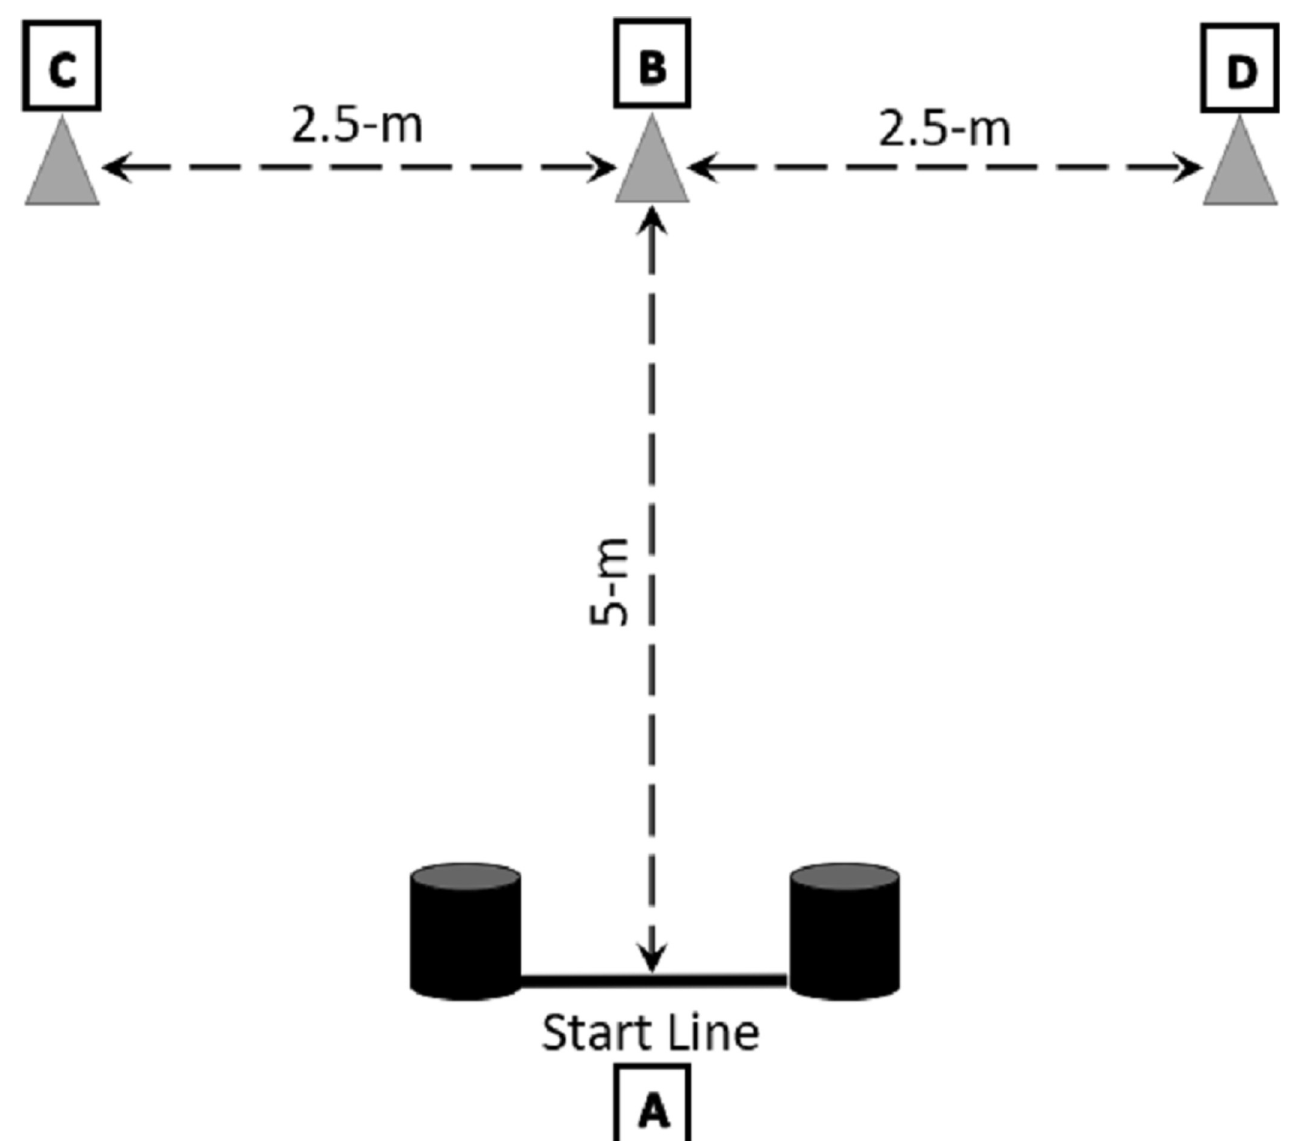
Fig 1. Illustration of the modified agility t-test assessment as used by Sassi et al. [35]. The grey triangles indicate the cones around which the athletes must run and shuffle. The black cylinder indicates the placement of timing gates (Microgate, Bolzano, Italy), set 1-m apart, 1-m in height and 1-m from the pre- marked start line/finish